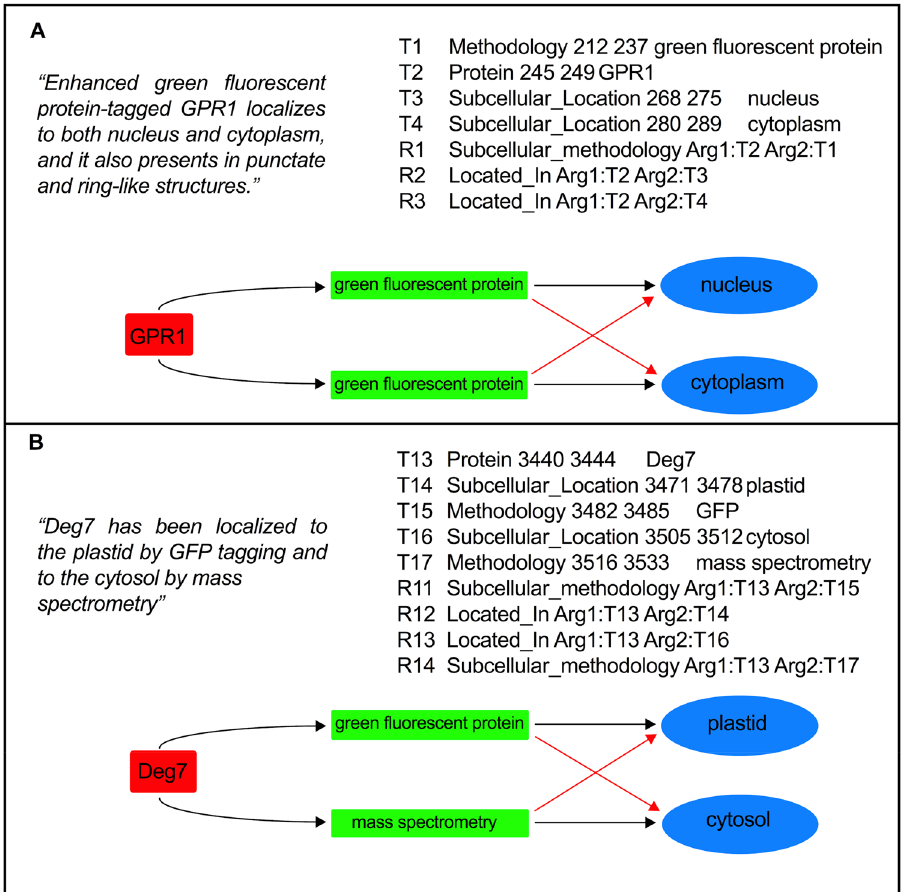
Figure 2. Two examples of protein subcellular information described in the SUBA corpus text and mapping of entity relationships. For both examples, the sentence from the article is quoted (top left), BRAT annotation defining the entities and relationships for that sentence in standoff format (top right) and a visual network representing the interaction between protein (red), experimental methodology (green) and cellular location (blue) is shown (bottom). The example shown in ( A ) is from Yang et al. and illustrates a simple semantic and syntactic relationship between the protein, GPR1, experimental methodology using green